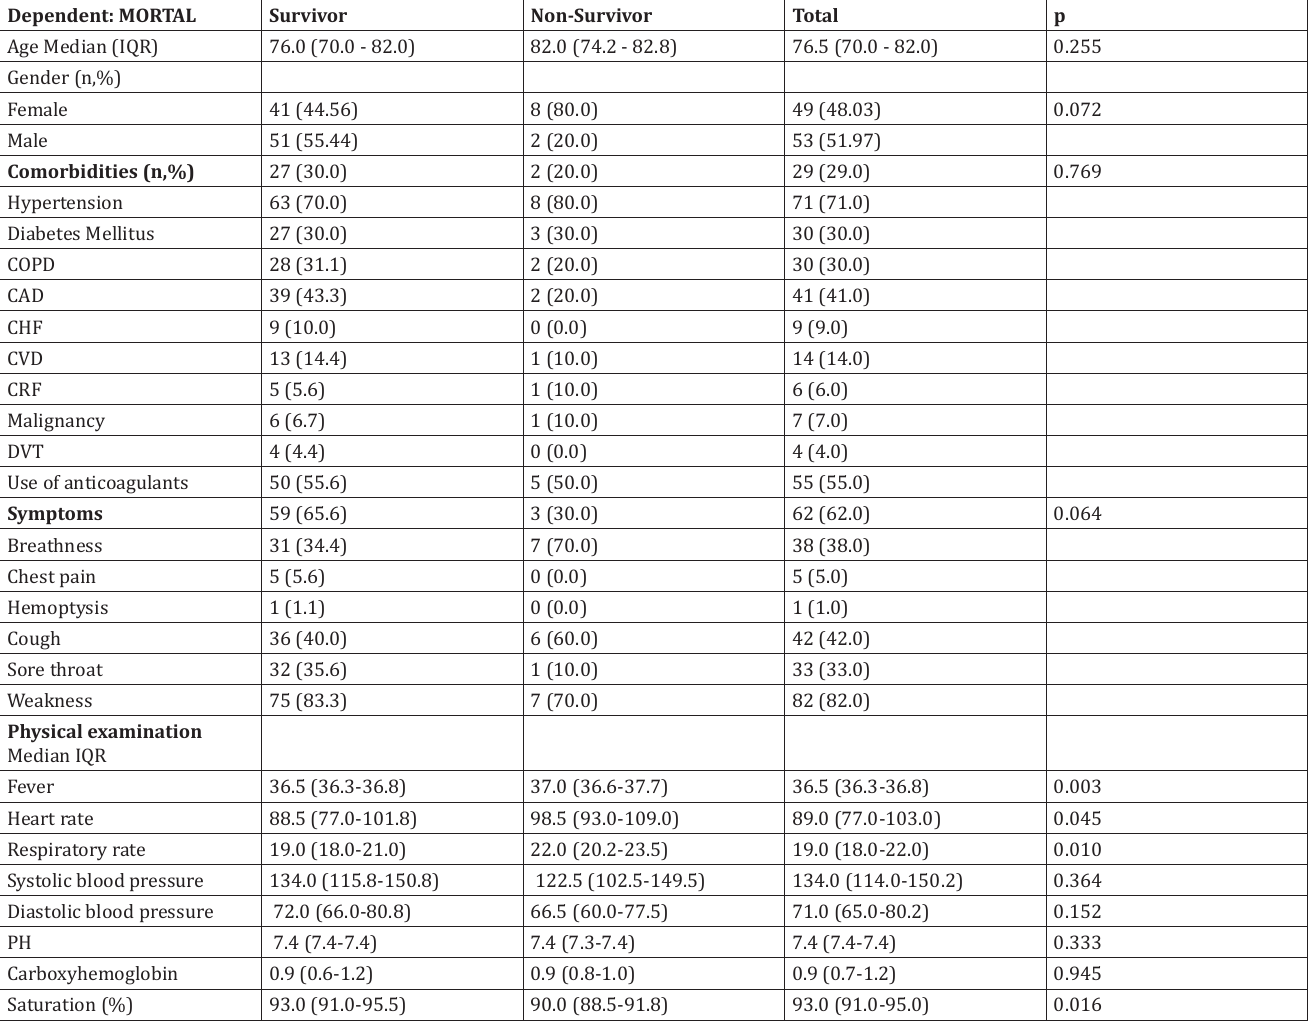
Demographic data, comorbidities, symptoms, examination findings and 30-day mortality of patients